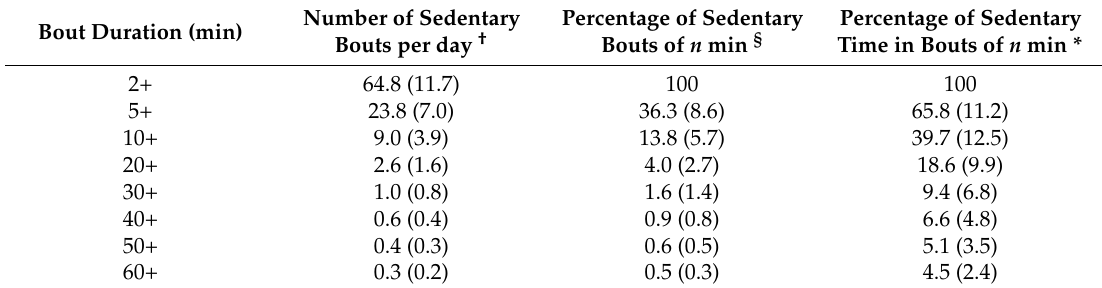
Table 5. Number of sedentary bouts · day − 1 , percentage of sedentary bouts and percentage of sedentary time of various bouts